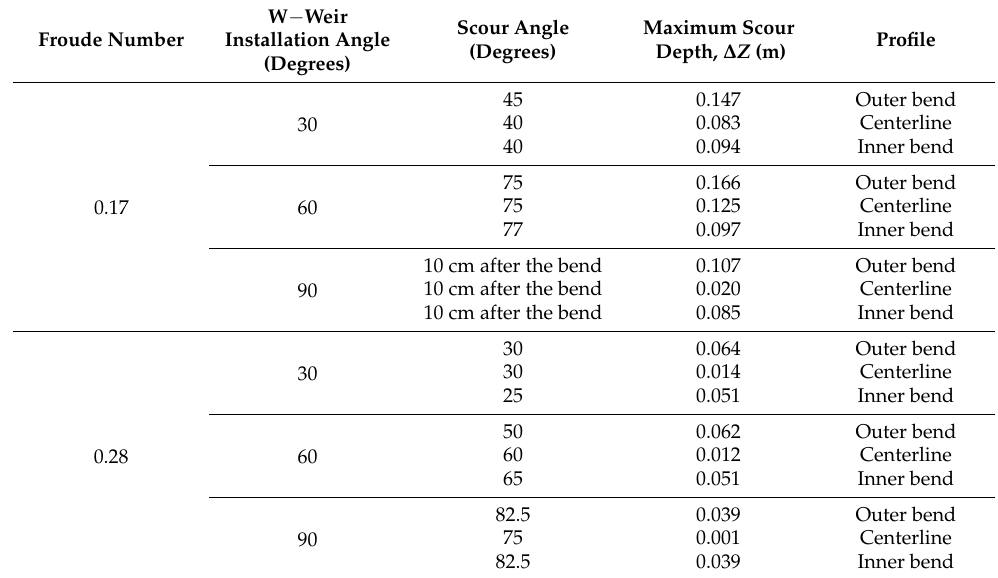
Table 2. The maximum depth of the scour holes for different Froude numbers and W − Weir installa- tion at 30, 60, and 90 degrees.